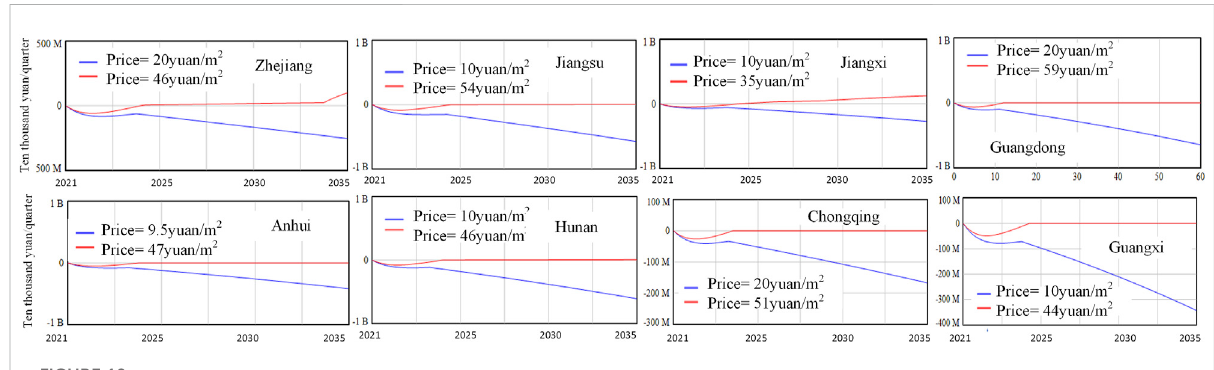
FIGURE 10 Simulation diagram of annual net pro fi t and loss of geothermal heating in non-central heating